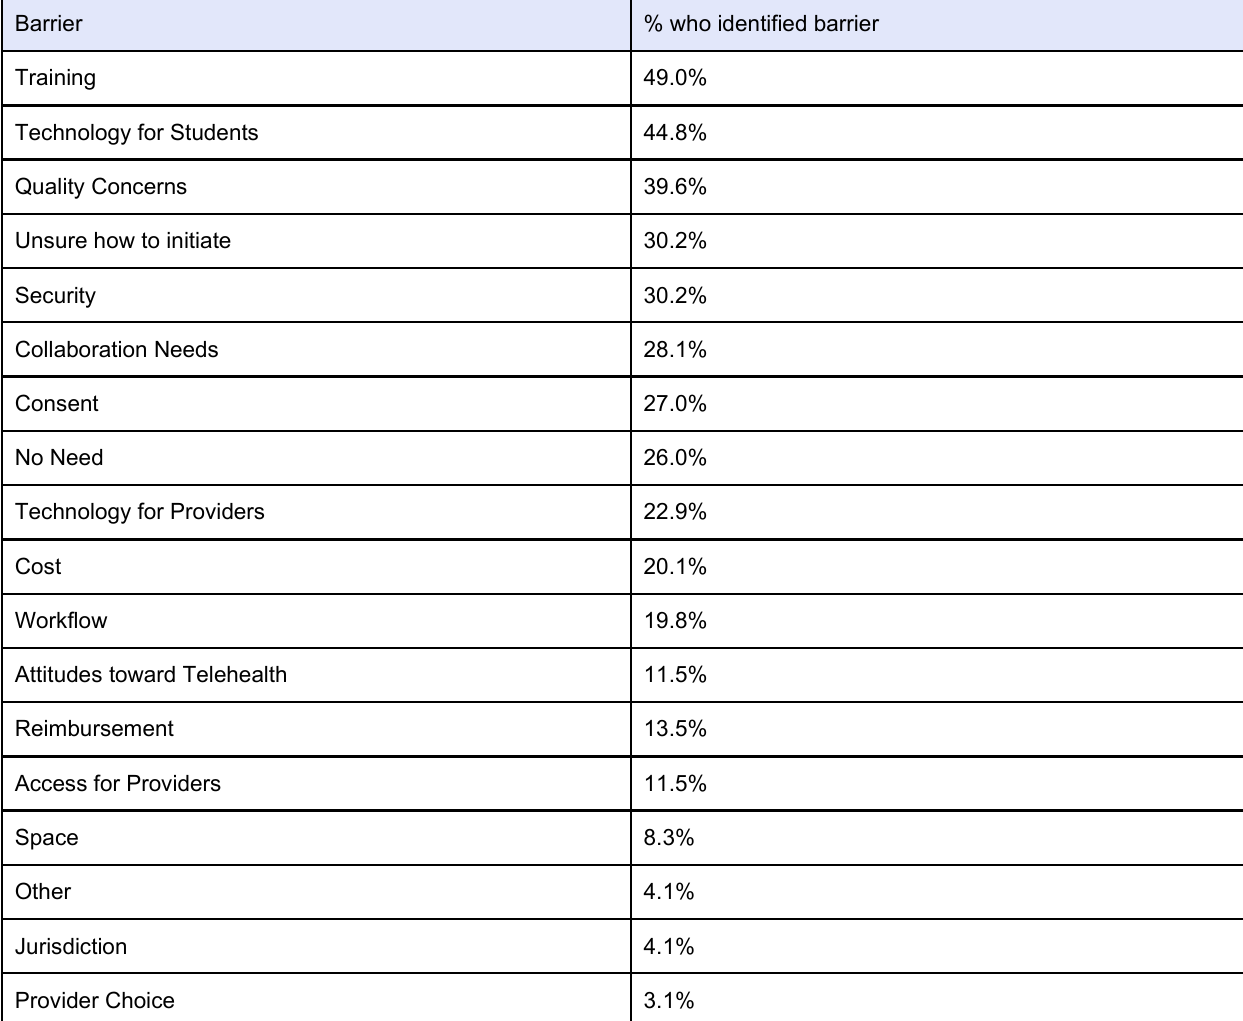
Identified Barriers to Implementation of Telehealth during the COVID-19 Pandemic Barrier % who identified barrier Training 49.0% Technology for Students 44.8%